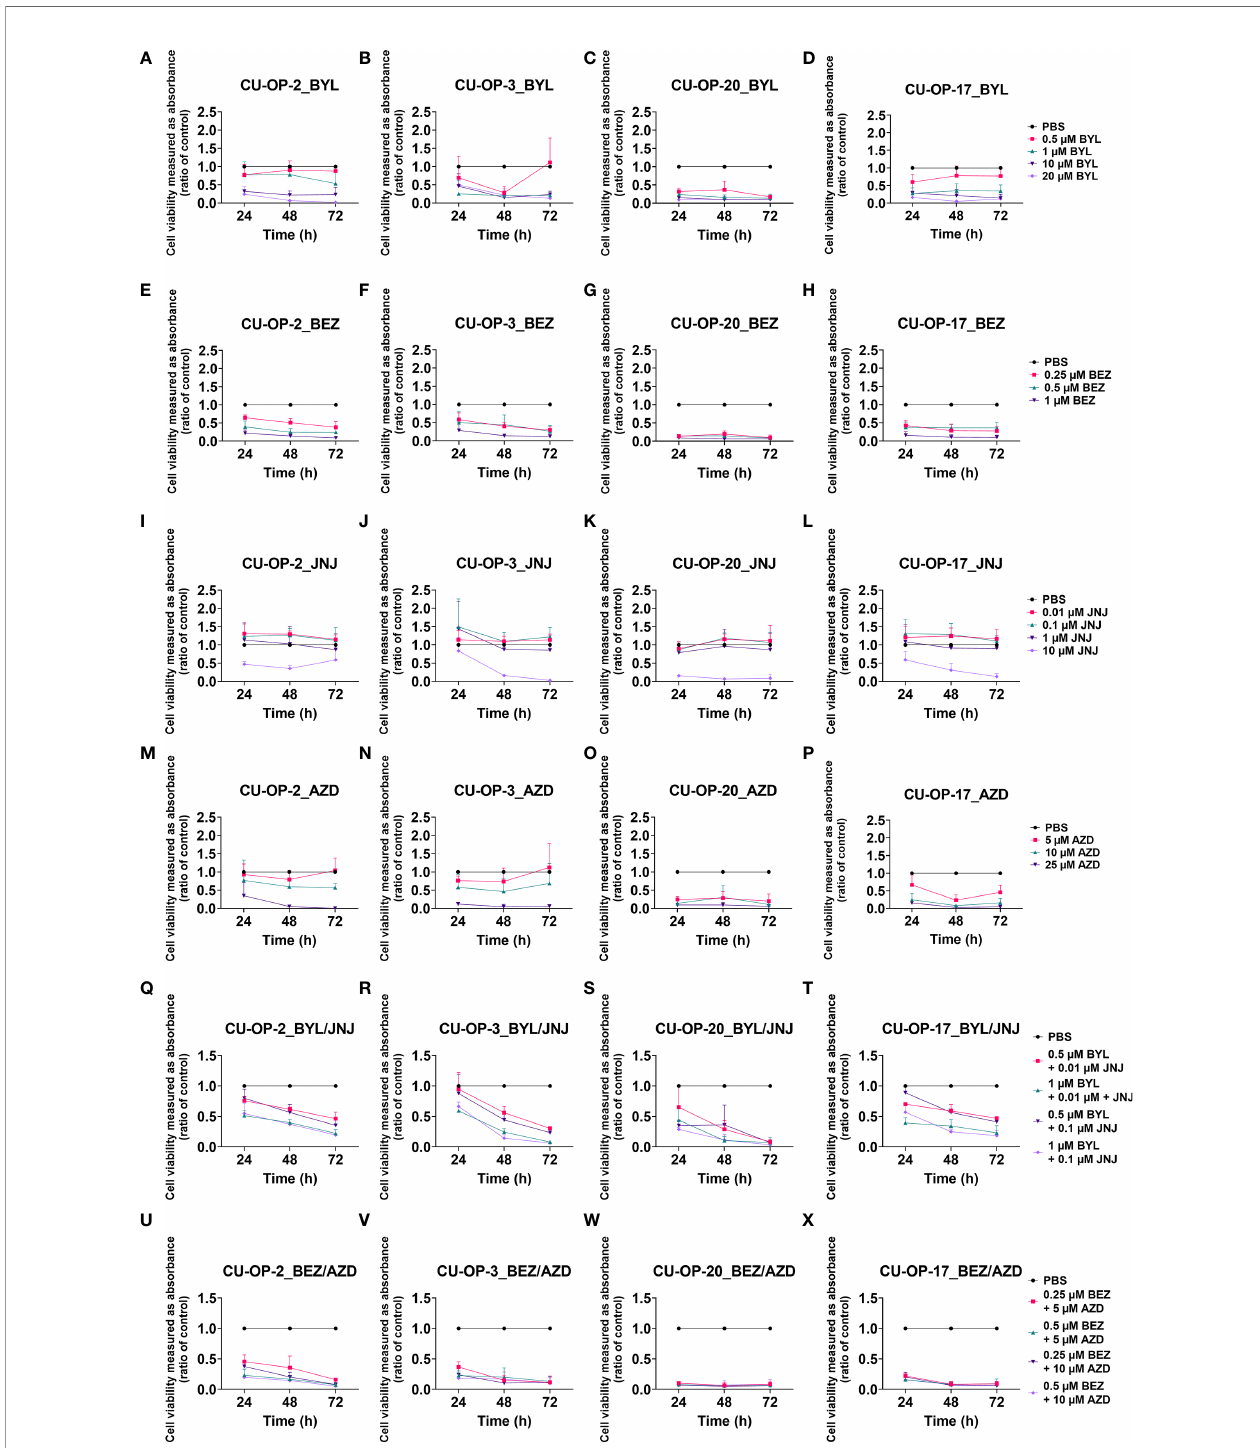
FIGURE 1 | WST-1 viability assays evaluating cellular metabolic capacity by absorbance on HPV + CU-OP-2, -3, -20 and HPV - CU-OP-17 cell lines upon treatment with PI3K inhibitors (BYL719, BEZ235), and FGFR inhibitors (JNJ-42756493, AZD4547). WST-1 viability assays measuring absorbance following treatment for 24, 48 and 72 h of HPV+ CU-OP-2, -3, -20 and HPV- CU-OP-17 with PI3K and FGFR inhibitors, BYL719 (A – D) ; BEZ235 (E – H) ; JNJ-42756493 (I – L) ; and AZD4547 (M – P) ; and combinational treatments with BYL719 and JNJ-42756493 (Q – T) ; as well as BEZ235 and AZD4547 (U – X) . The graphs represent three experimental runs per cell line, and results are presented as the mean ± standard deviation. BYL denotes BYL719; BEZ denotes BEZ235; AZD denotes AZD4547 and JNJ denotes